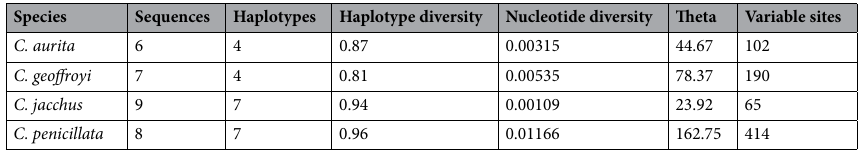
Table 2. Callithrix diversity